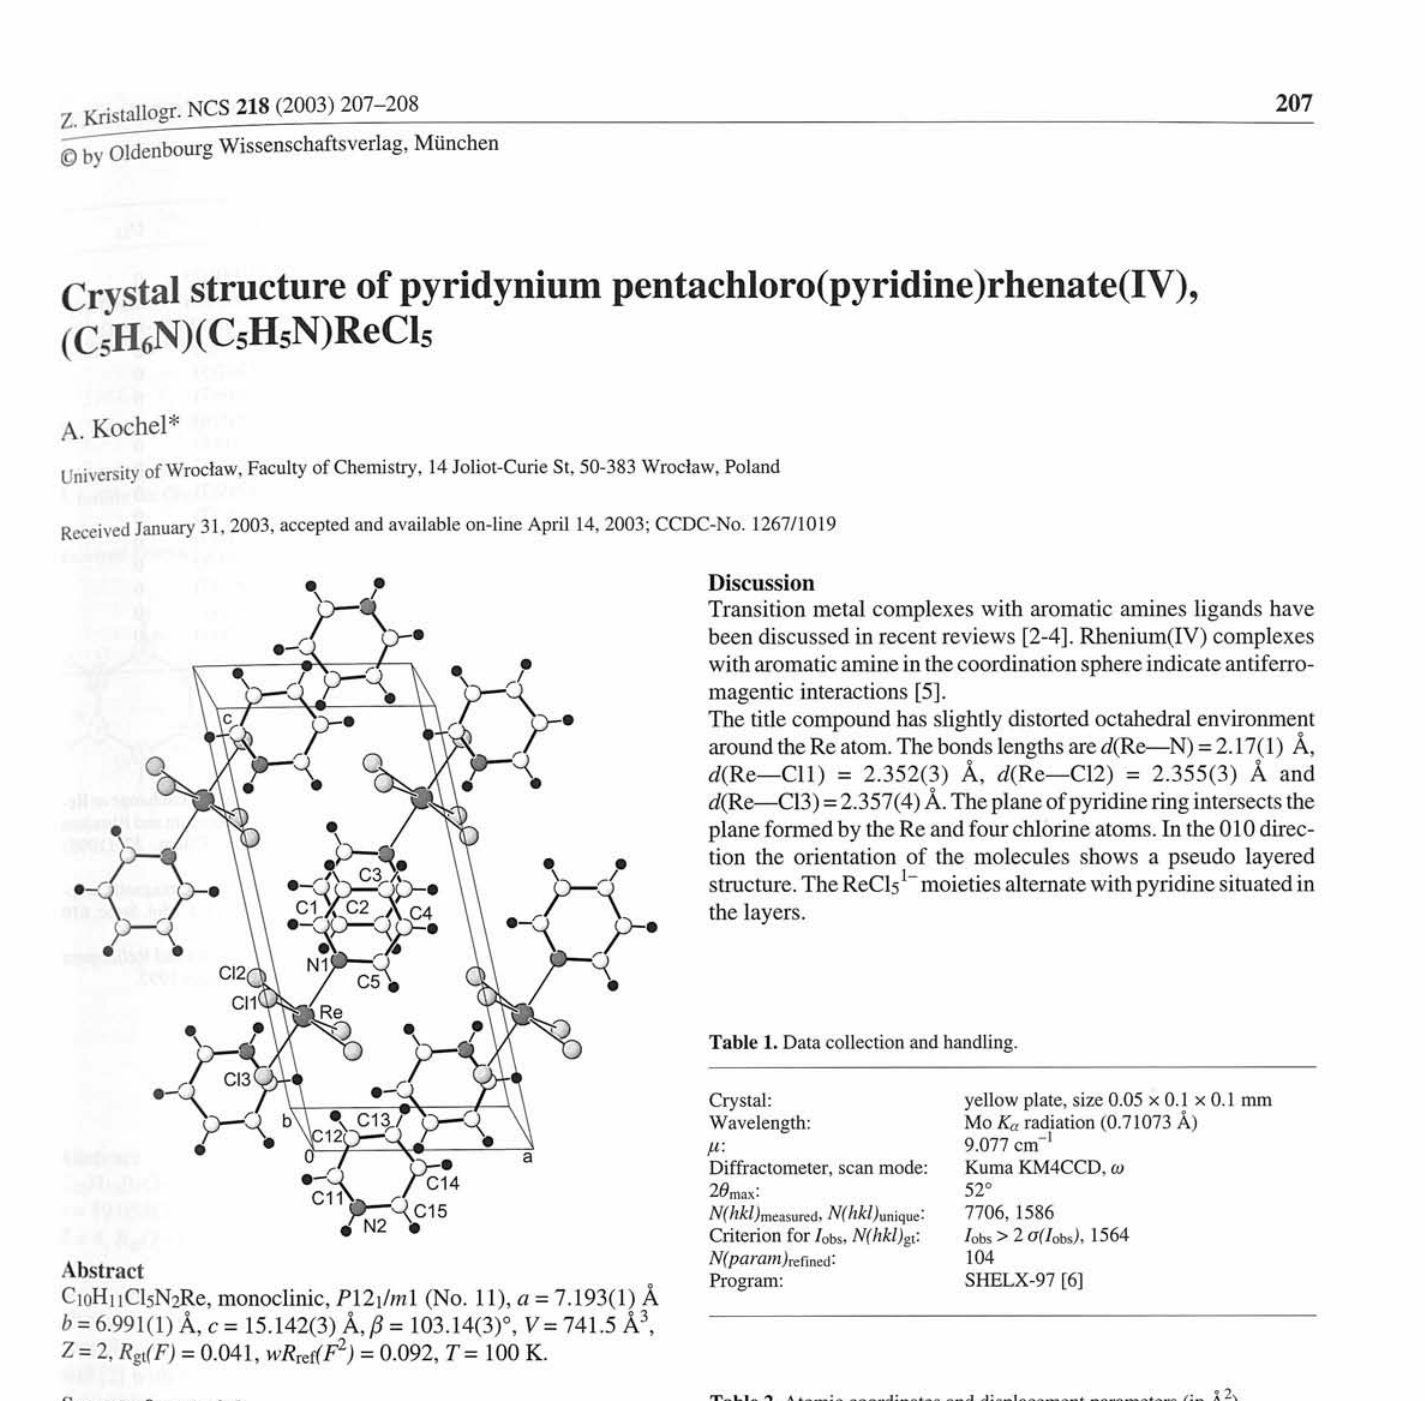
Table 2. Atomic coordinates and displacement parameters (in A